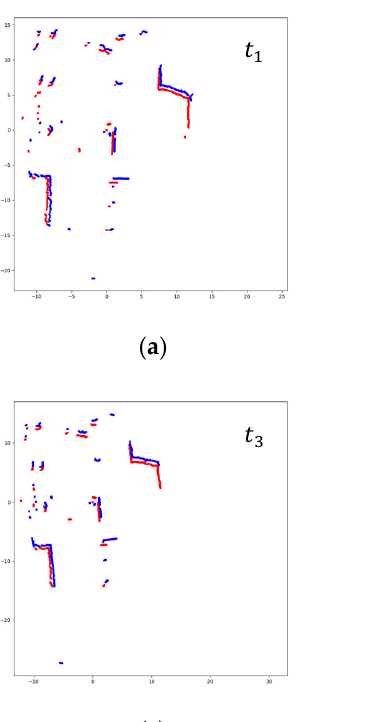
Figure 6. The generation of training images. ( a ) Raw scan range data in polar form; ( b ) ICP scan matching; ( c ) plotting of matched scans in Cartesian form.